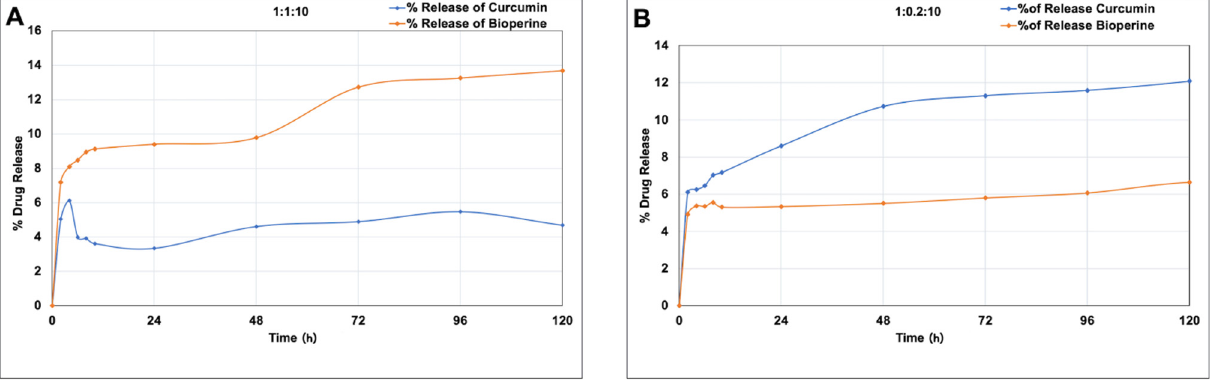
Figure 3. In vitro drug release of curcumin and Bioperine from the curcumin-Bioperine PLGA NPs ( A ) 1:1:10 and ( B ) 1:0.2:10 at pH 7.4 PBS buffer 37 °C for 5 days. at pH 7.4 PBS buffer 37 ◦ C for 5